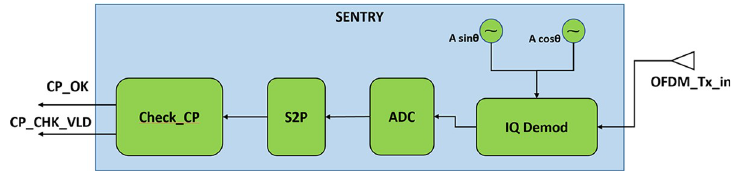
Fig 13. Detailed block diagram of